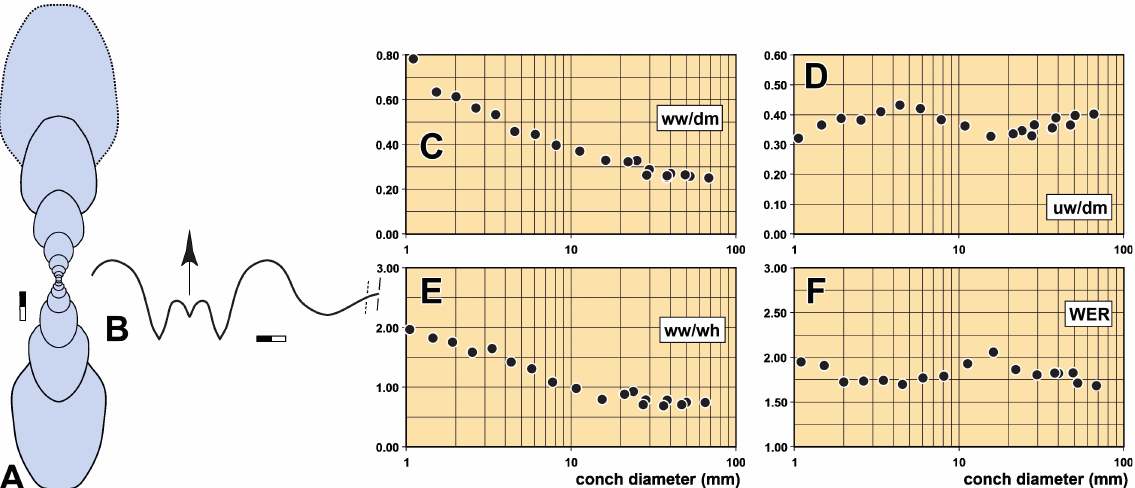
Fig. 12. Ponticeras materni sp. nov. A . Cross section of paratype MB.C.22158, probably from Oberscheld. B . Suture line of paratype MB.C.22175 (Zimmermann 1936 Coll.) from Oberscheld (Prinzkessel